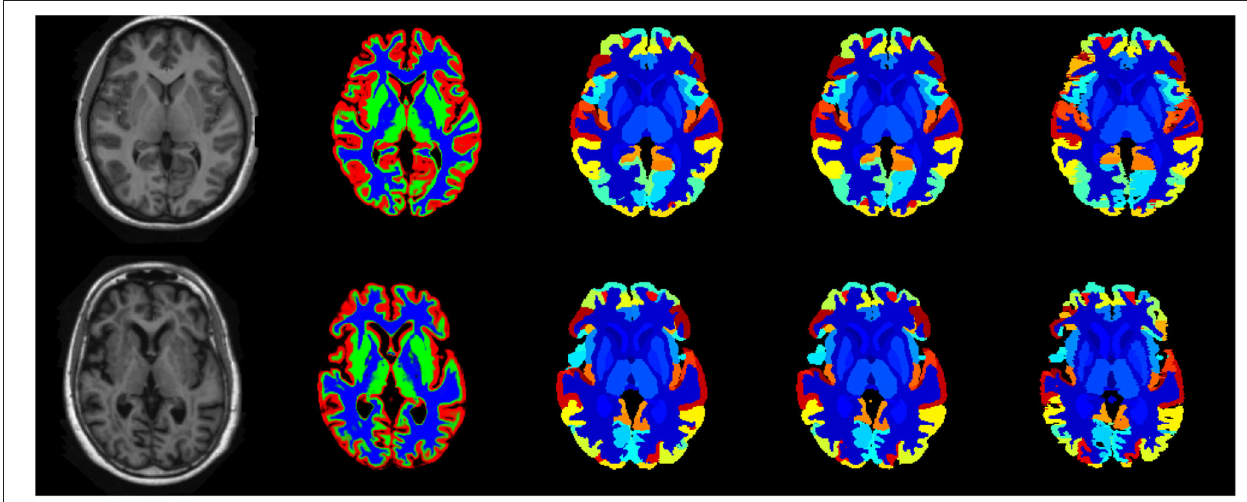
FIGURE 8 | Best case (scan 1,038, top row) and worst case (scan 1128, bottom row) labellings from the fusion challenge dataset. The figure shows the original T1w scan (first column), the tissue classes (second column) identified using the method of Brudfors et al. (2020), the majority voting labelling (third column), the predicted labels using the proposed FIL method (fourth column) and the manually defined ground truth labels (fifth column).